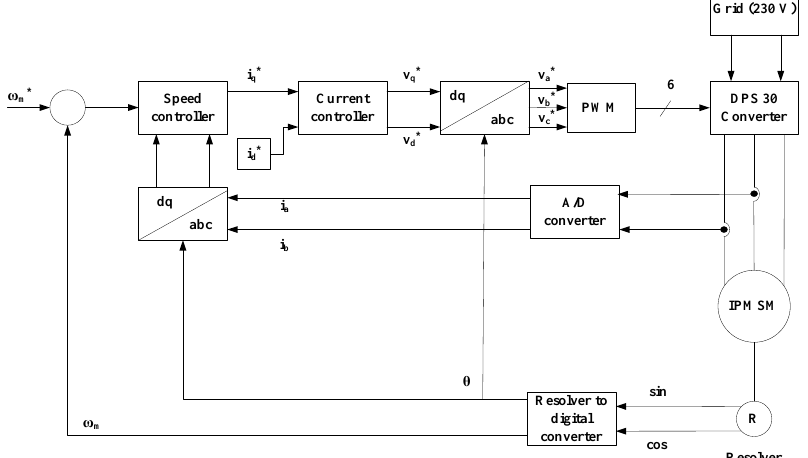
Figure 2. Block diagram of the control system taken into account.